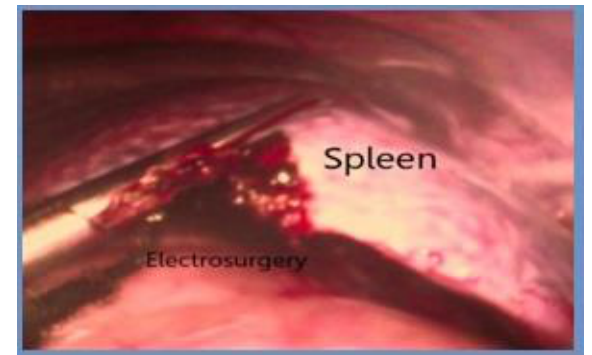
Figure, 6: Photograph of group B electro-surgery used to cutting through splenic parenchyma